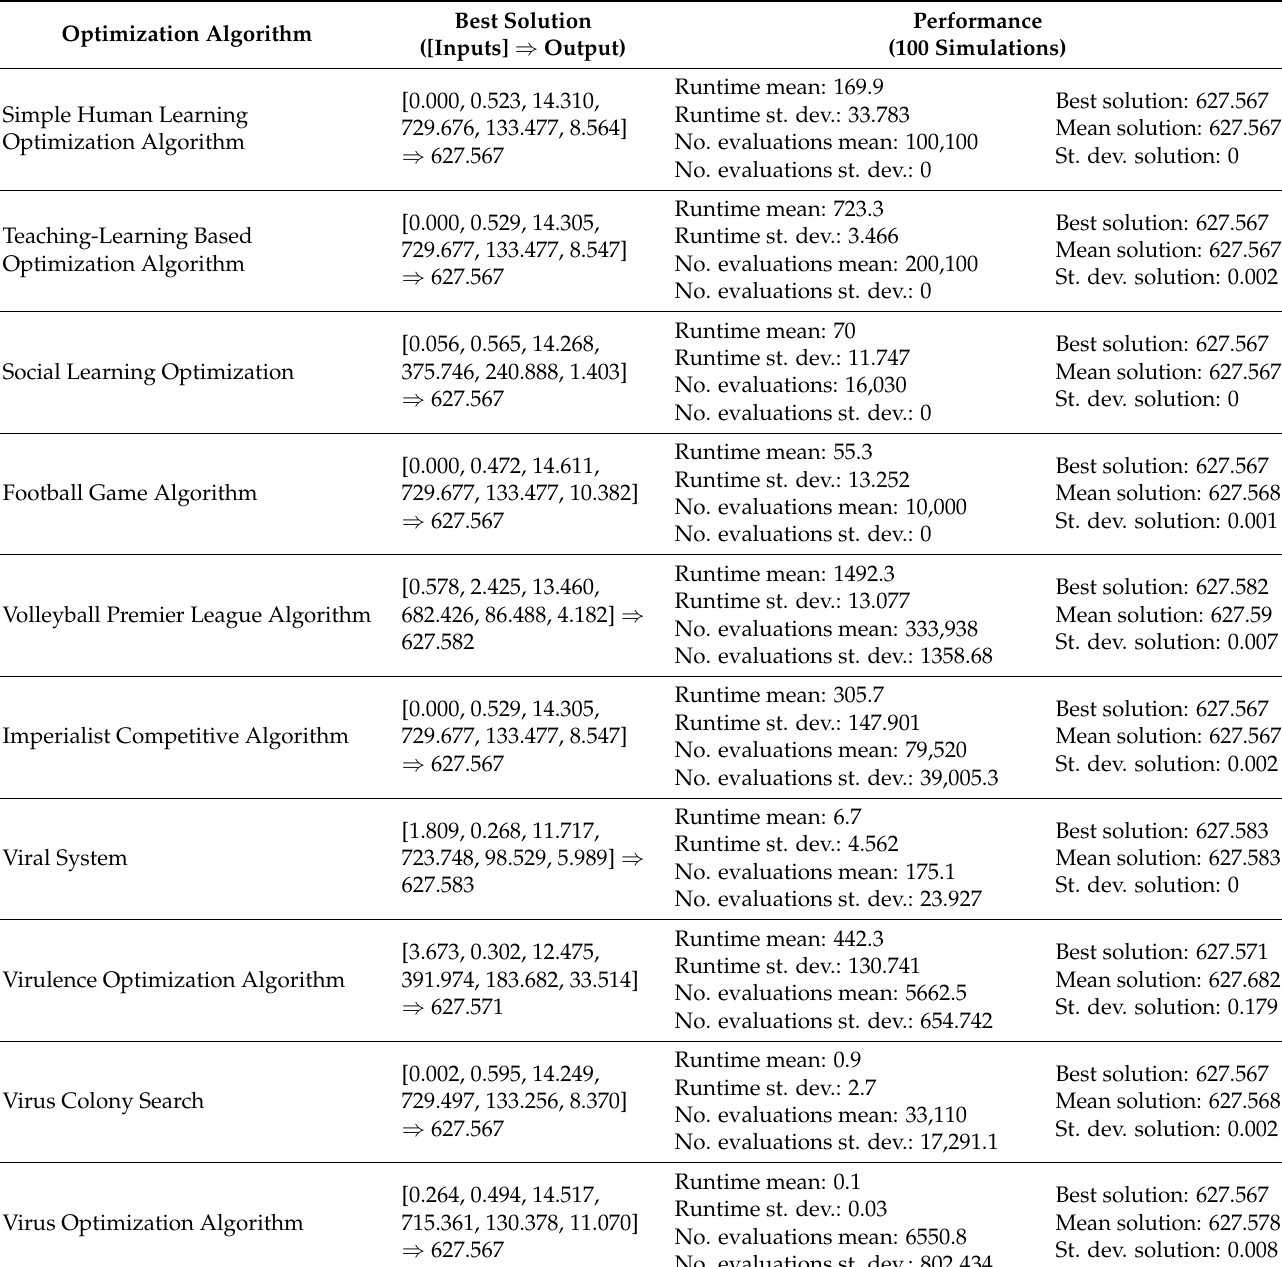
Table 3. Results obtained with biologically inspired optimization algorithms for CO (mg/m 3